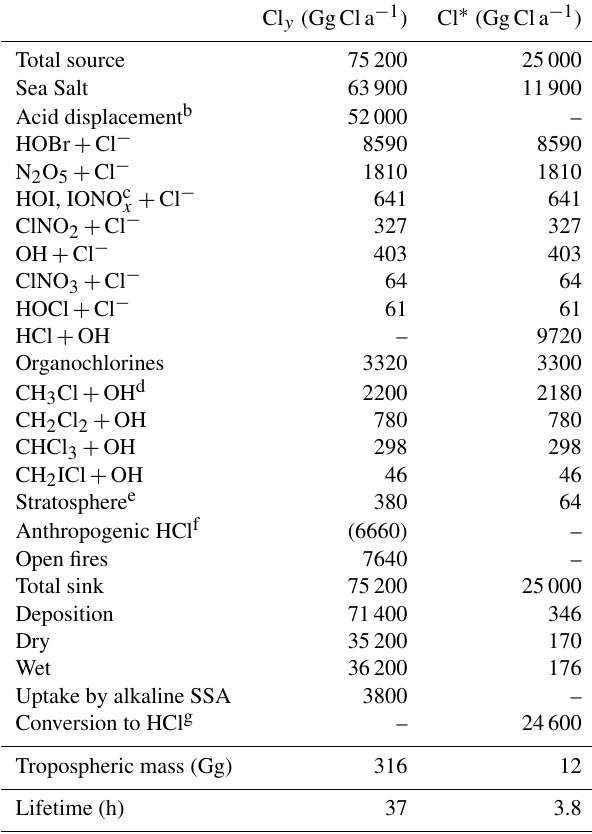
Table 1. Global sources and sinks of gas-phase inorganic (Cl y ) and reactive (Cl ∗ ) tropospheric chlorine a